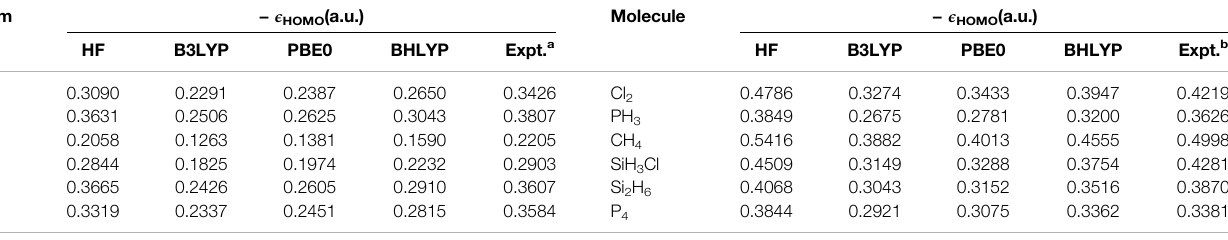
TABLE 8 | Negative HOMO energies, − ϵ HOMO (in a.u.) for atoms and molecules using HF, B3LYP, PBE0 XC functionals. For details, consult Ghosal et al. (2019). Atom −  HOMO (a.u.) Molecule −  HOMO (a.u.)